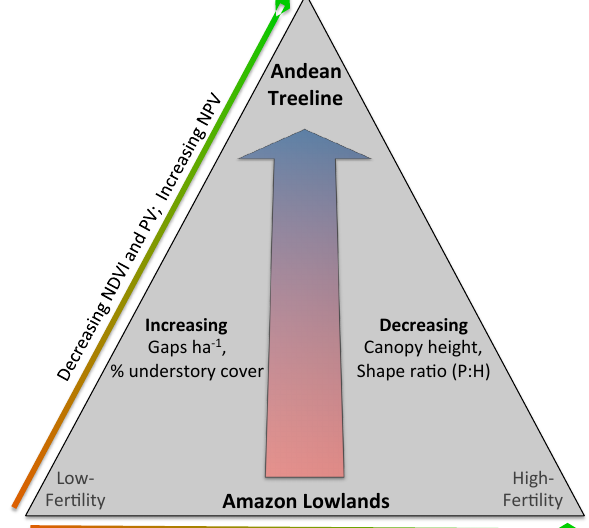
Decreasing NDVI and PV; Increasing NPV, CH, P:H Fig. 10. Summary of results presented in the study: as elevation increases from the Amazon lowlands to Andean treeline, the for- est canopy undergoes increases in canopy gap density and under- story plant cover, while canopy height and shape ratio ( P : H ) de- crease. Functional trait metrics of NDVI and fractional PV cover decrease, while fractional NPV cover increases, from low-fertility sites in the lowlands to Andean treeline. A similar trend occurs from low- to high-fertility lowland sites. Additionally, canopy height and the shape ratio increase from low- to high-fertility sites within the